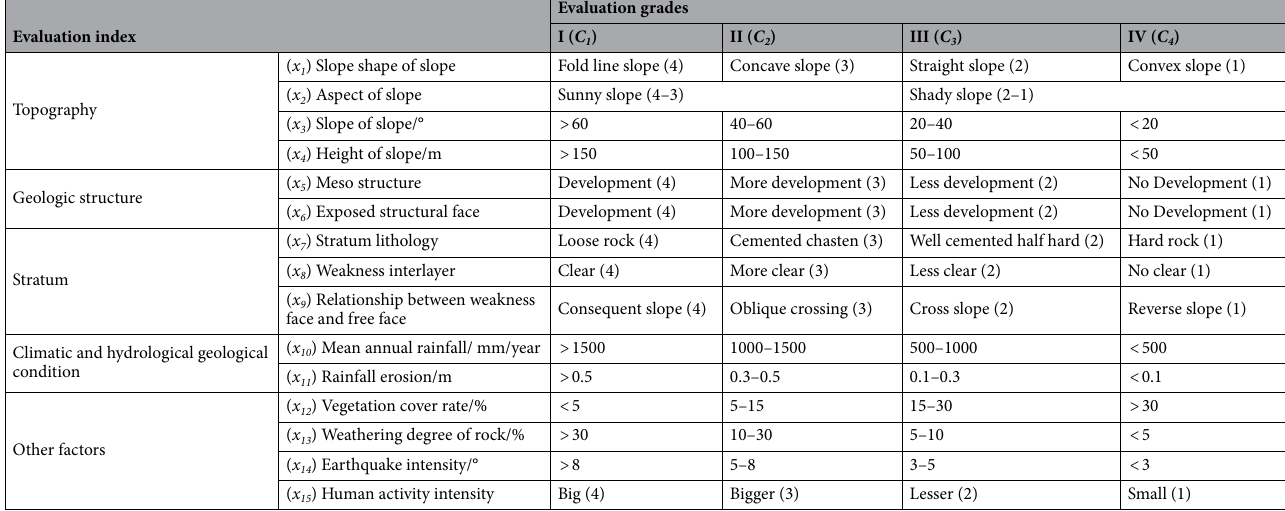
Table 1. Evaluation factors and grading standard of highway landslide